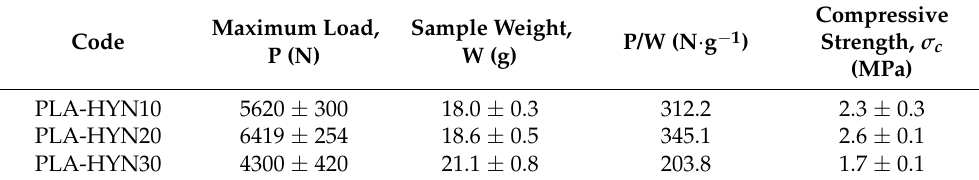
Table 3. Flatwise compressive properties of PLA-based sandwich structures with PLA honey- comb